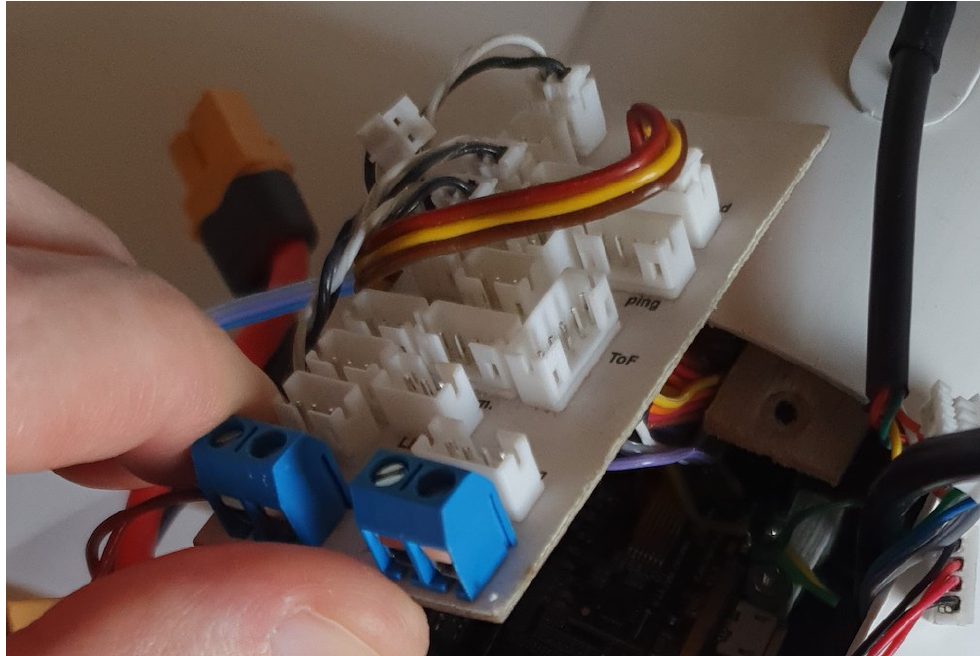
Figure 19. A dedicated connector board improves the maintenance because the flight controller board is mounted deep inside the drone’s